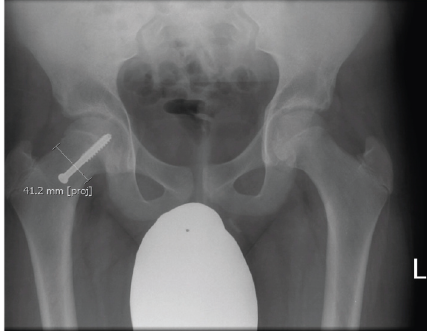
Figure 2: Neck width measurement. Neck width is measured at the narrowest point of the neck. This measurement is used to assess proximal femoral